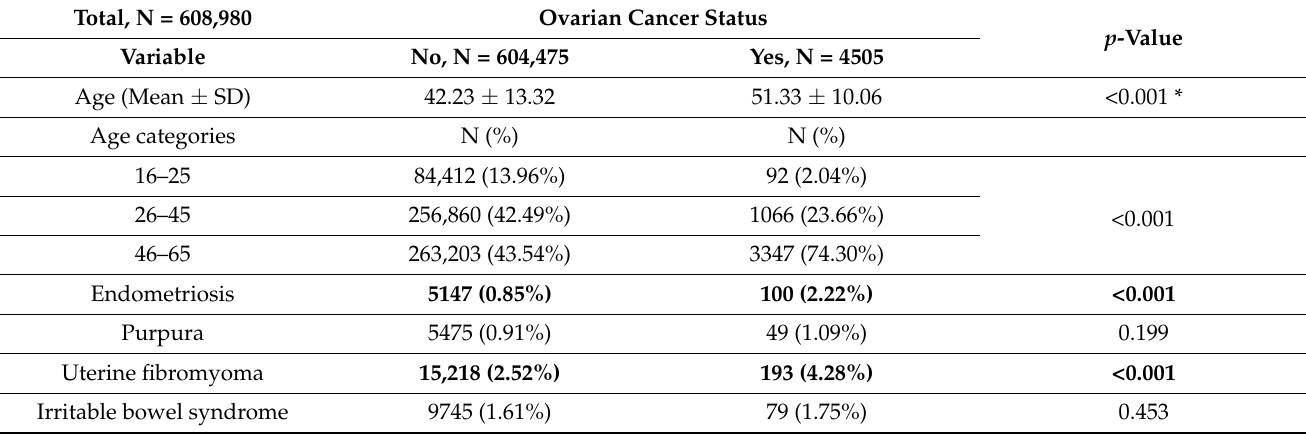
Table 2. Bivariate analysis: the relationship between ovarian cancer and each of the other